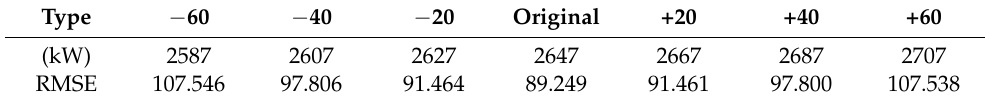
Table 2. Root mean square error (RMSE) values excluding the heavy